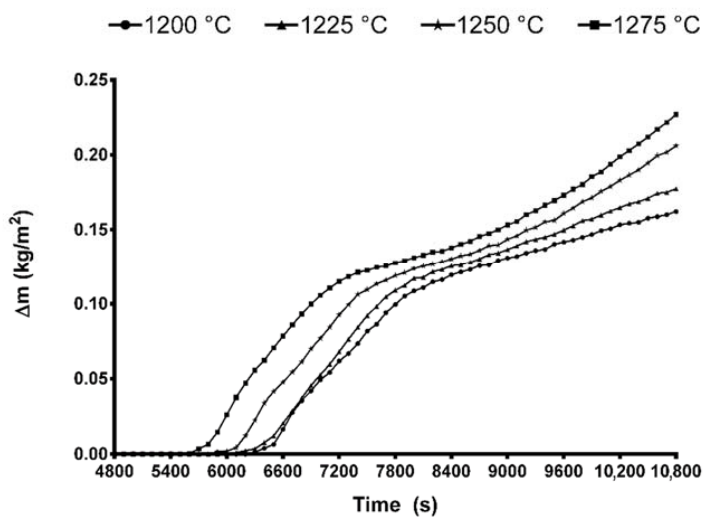
Figure 5. TG results from oxyfuel atmosphere.